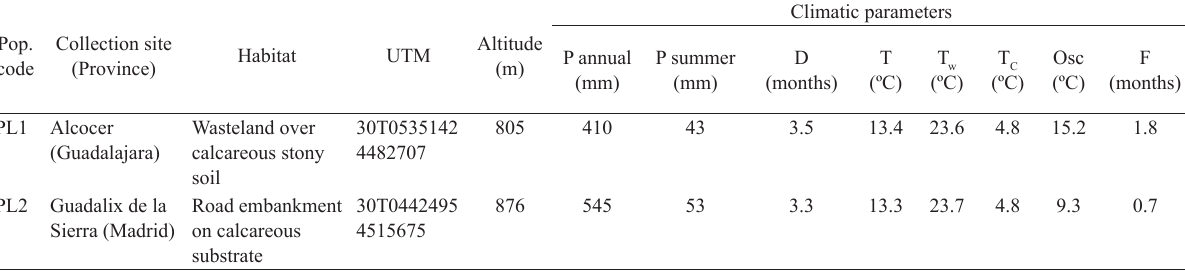
Table 1. Habitat, collection site and climatic parameters of two Plantago lanceolata populations. Abbreviations are: total precipitation per year (P annual), precipitation June-August (P summer), number of drought months (D), annual mean temperature (T), mean temperature of the warmest month (Tw), mean temperature of the coolest month (Tc), annual mean of daily thermal oscillation (Osc), number of frost months (F). Universal Transverse Mercator (UTM). Climatic data from Spanish State Meteorological Agency (AEMET). All seeds were collected in July 2014.